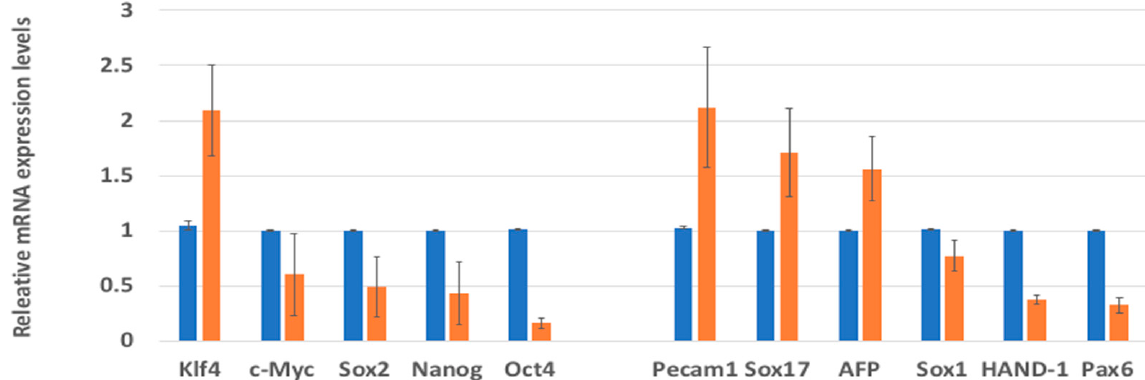
Figure 4. RT-qPCR analysis of H9 hESC cultured in homemade medium containing 100 ng/mL of hFGF-2 (blue bar) or hDJ-1 (orange bar) after ten passages.